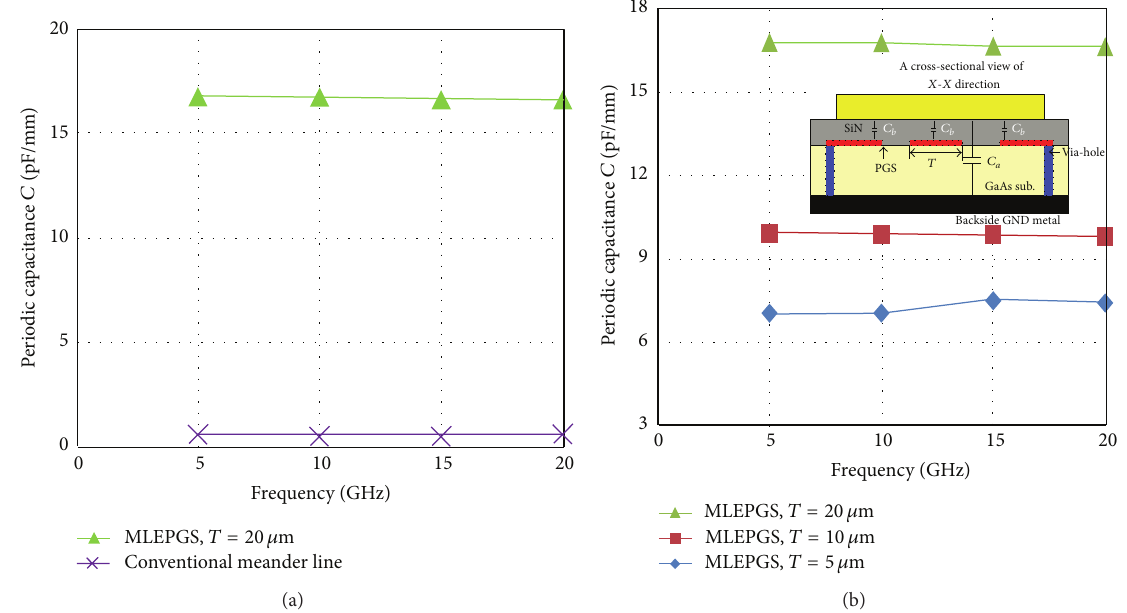
Figure 3: (a) Measured equivalent periodic capacitance of the MLEPGS with 𝑇 of 20 𝜇 m and conventional meander line and (b) equivalent periodic capacitance of the MLEPGS with various 𝑇